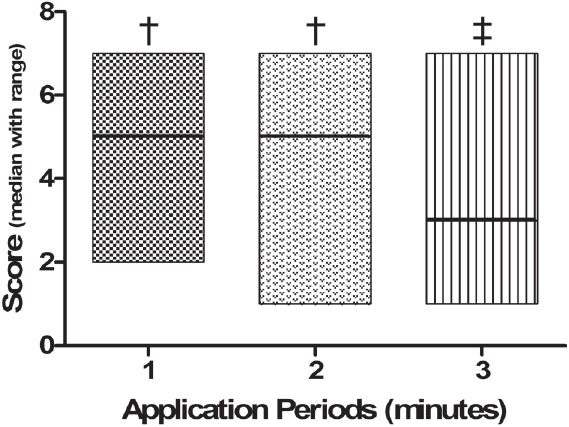
Figure 7- Median with range of the scores obtained for the three application methods of the sodium citrate.